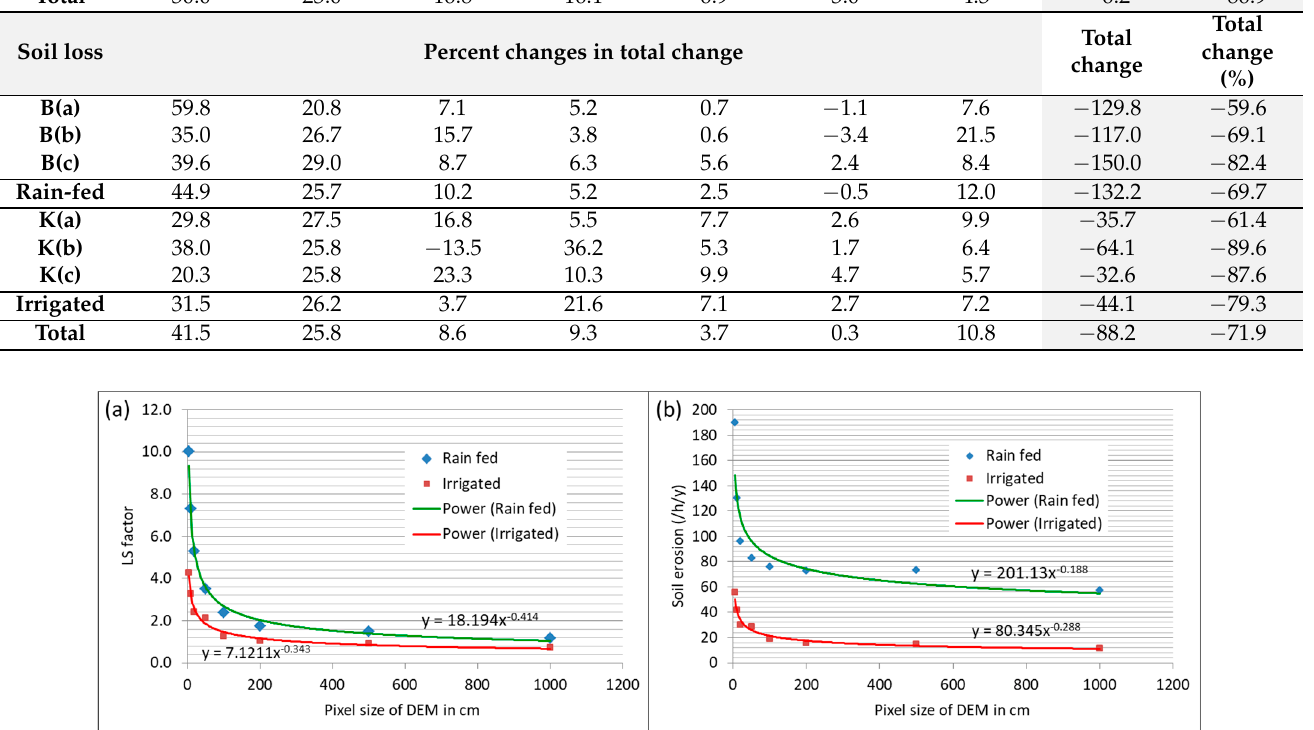
Figure 6. Changing trend of LS factor ( a ) and soil erosion ( b ) in the rain fed and irrigated plots with the variation of DEM resolution.